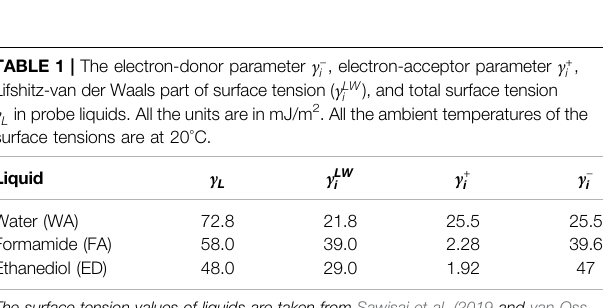
c The square root is negative. The error is larger than the value